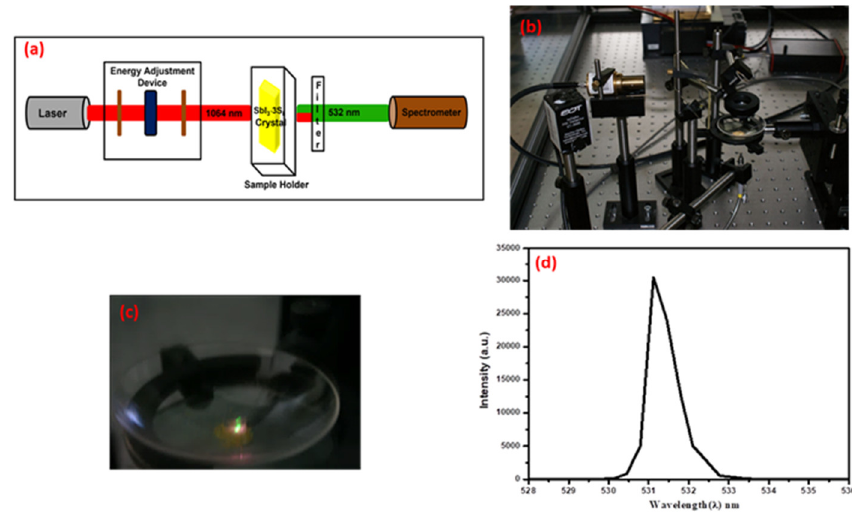
Figure 10. ( a ) Schematic diagram of the experimental set-up of SHG. ( b ) Digital image of the test stand for SHG generation in SbI 3 · 3S 8 crystals, ( c ) a shining piece of the crystal SbI 3 · 3S 8 during the generation of the second harmonic of light, and ( d ) spectral characteristics of the second harmonic of light generation for the repetition frequency of 0.85kHz.